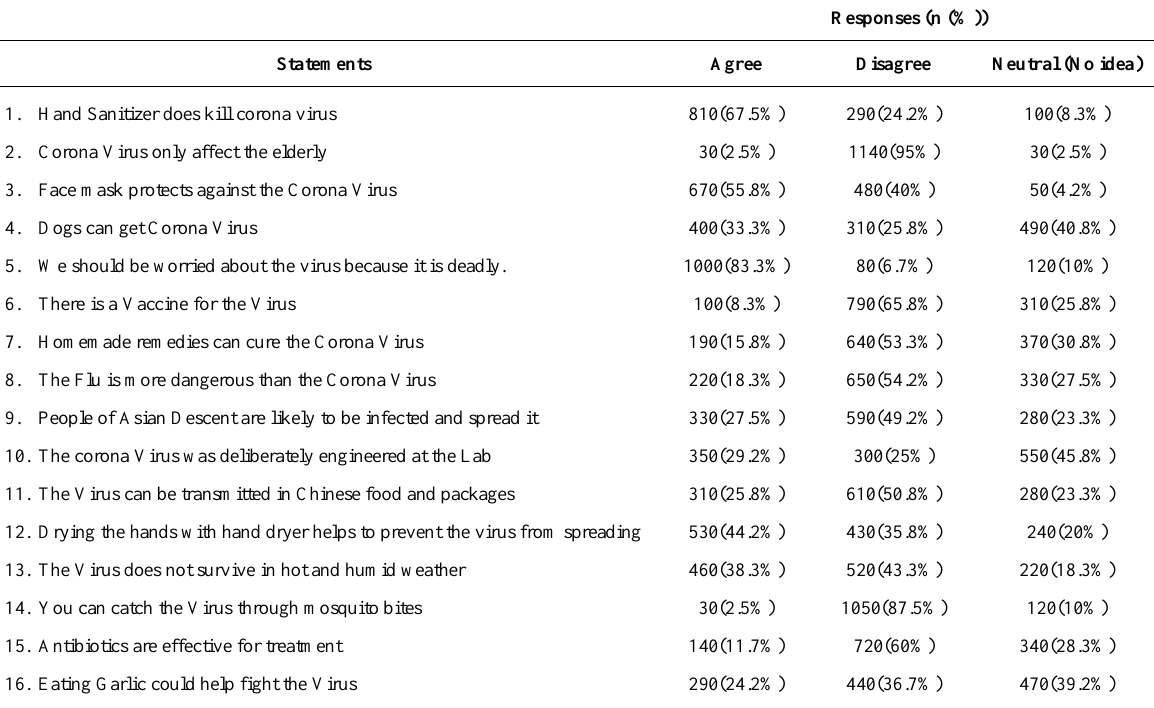
Table 2. Responses to the